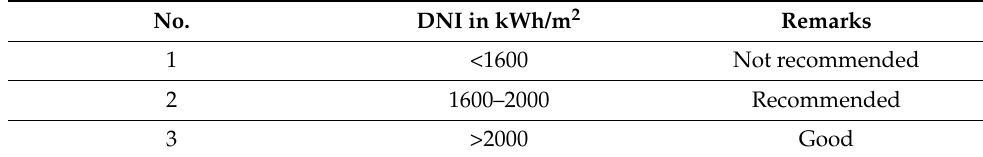
Figure 3. Daily solar assessment atdifferent locations.